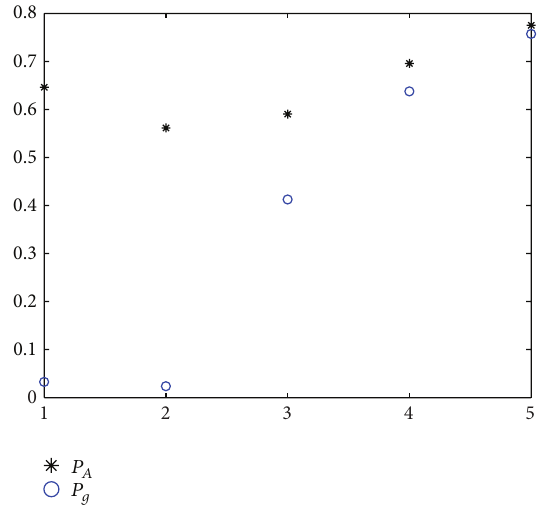
Figure 1: Comparison of two probabilities with ratio ≥ 1.